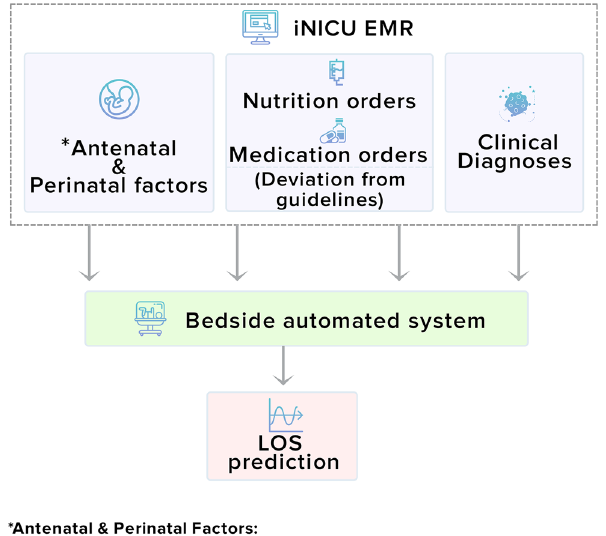
Figure 1. Overview of bedside automated system for predicting length of